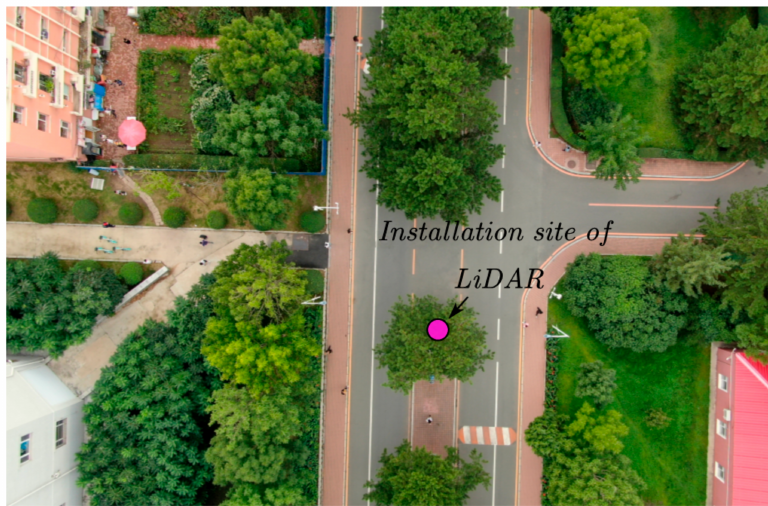
Figure 19. Aerial photography of the installation